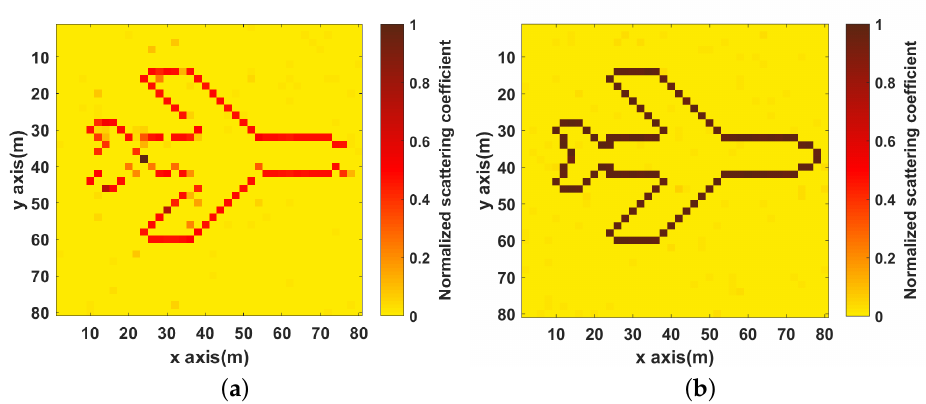
Figure 12. Imaging results under different center frequencies ( a ) 1 GHz; ( b ) 40